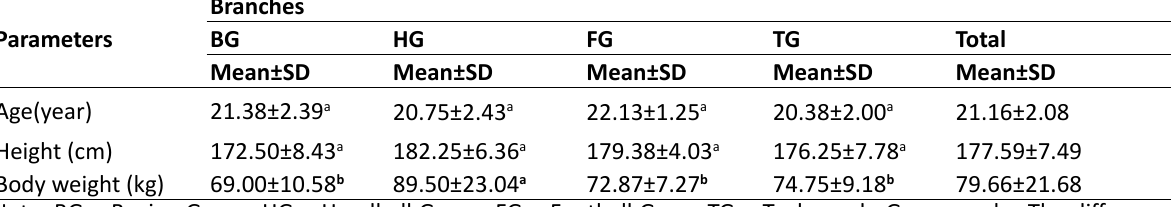
Table 1. Descriptive information of the participants.